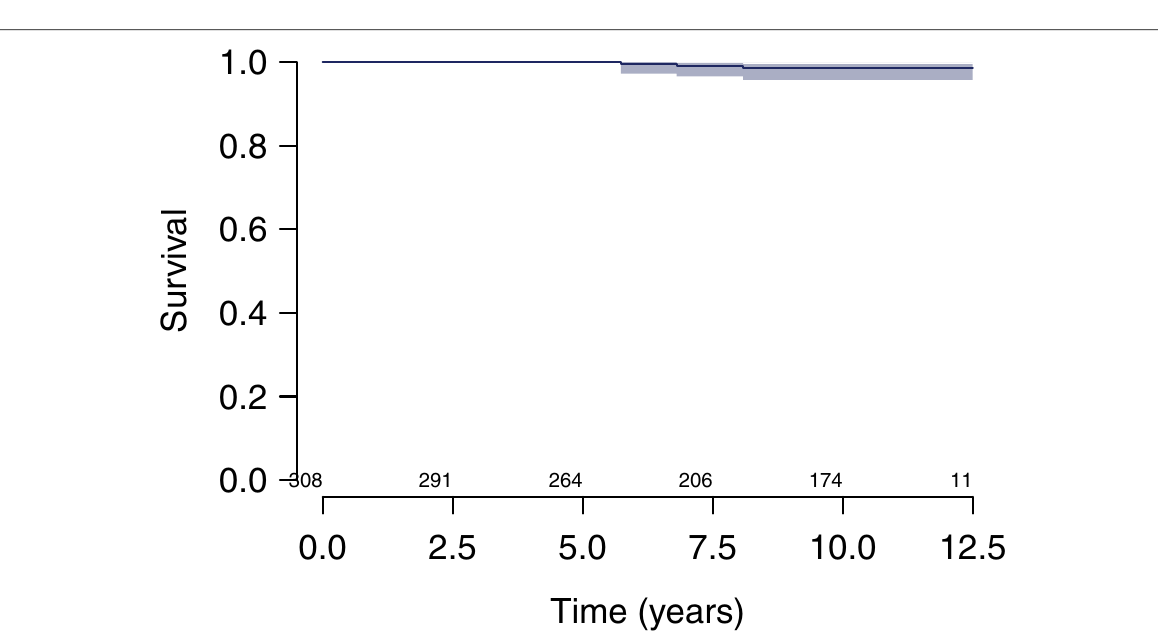
Fig. 3 Survival at 10 years estimated using the KM method was 98.6% (CI, 95.8–99.6%) considering cup revision for aseptic loosening as